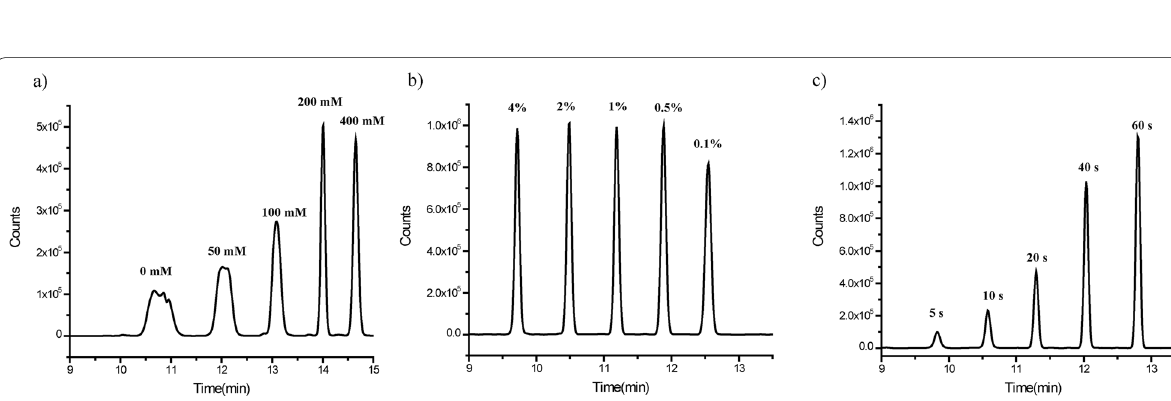
Fig. 2 Effects of different experiment conditions on MS responses by multi-injection, taking Cys as an example: a salt concentration, b acid concentration, c injection